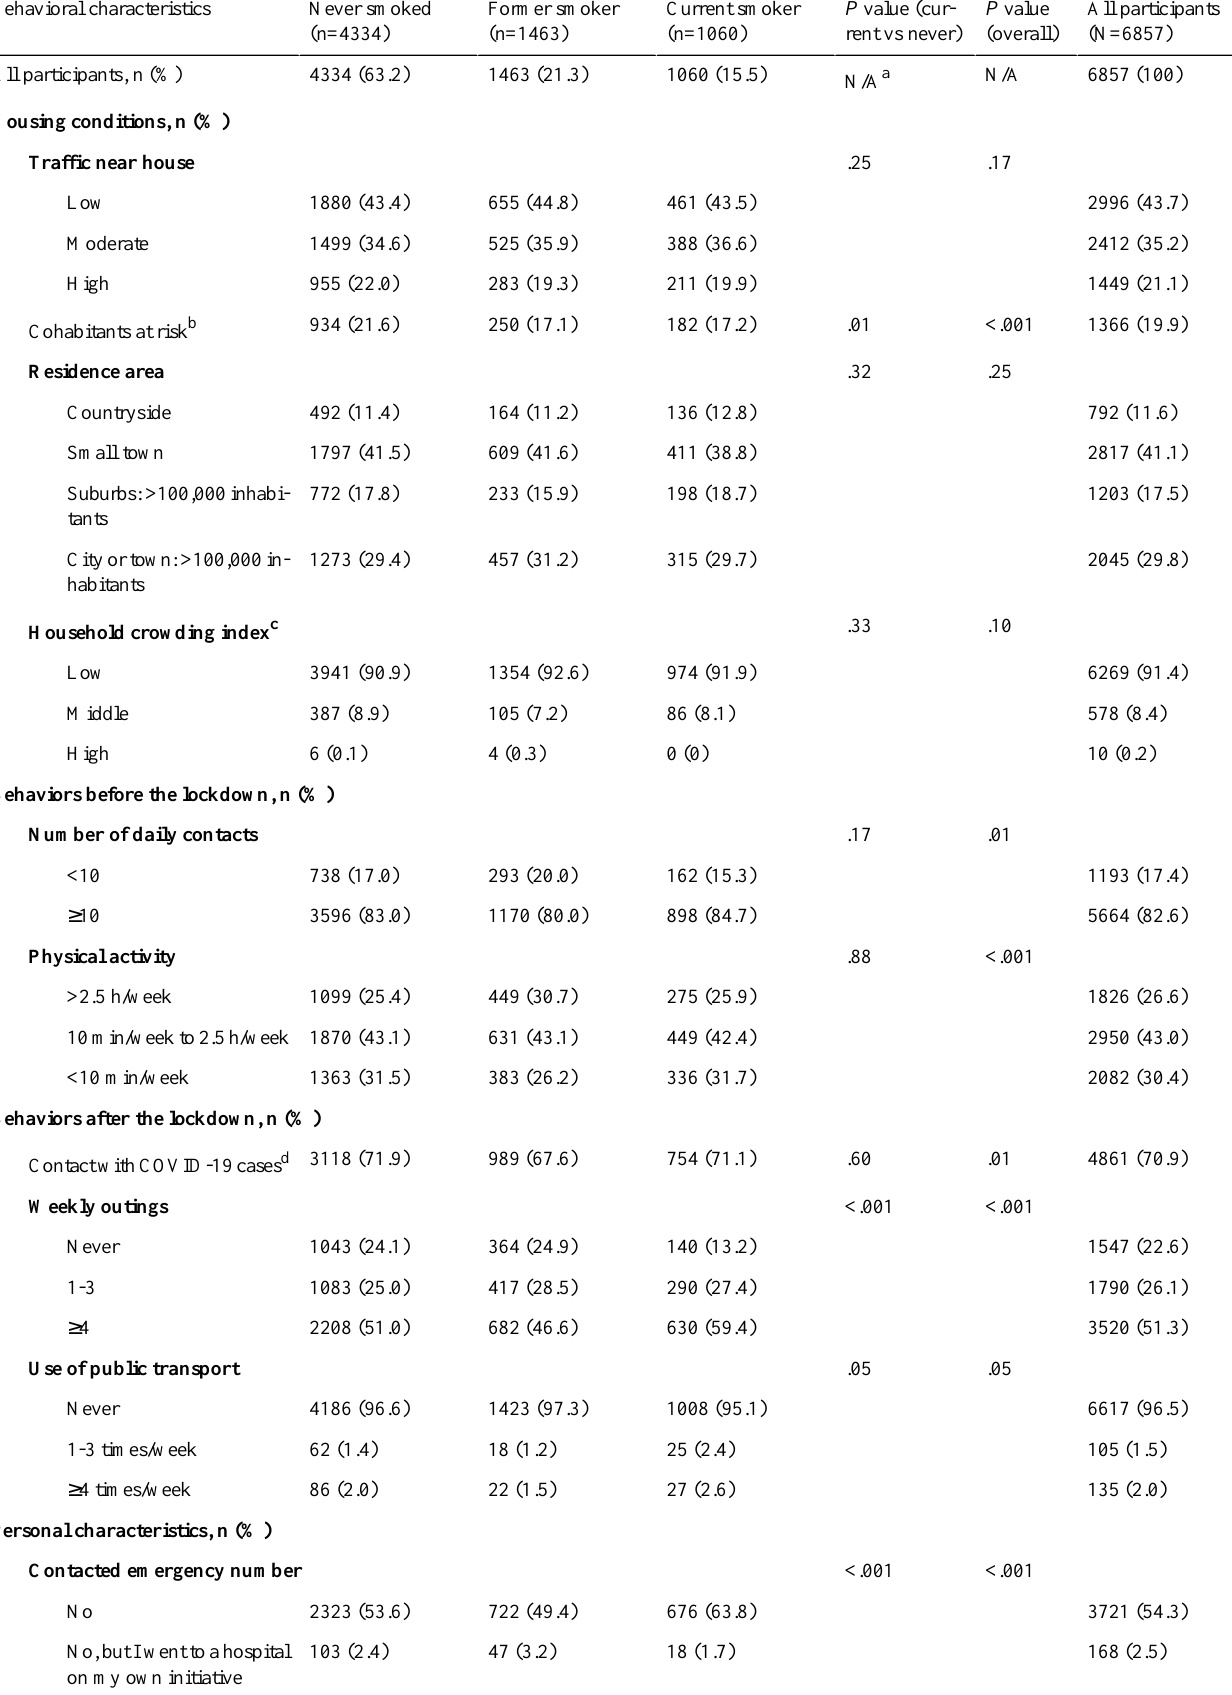
Table 3. Behavioral characteristics of study participants with known molecular test results by smoking status in Italy, from April 13 to June 2, 2020